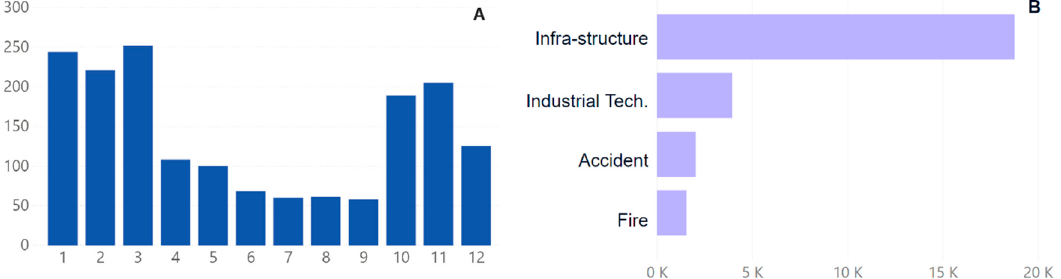
Figure 8. The number of infrastructure incidents distribution per month of the year, where 1 is the 1st month, January, and 12th, the last, December (A) and influence of weather conditions—rain precipitation in mm 3 per incident type. Values in the period of 2011 to 2018 (B).